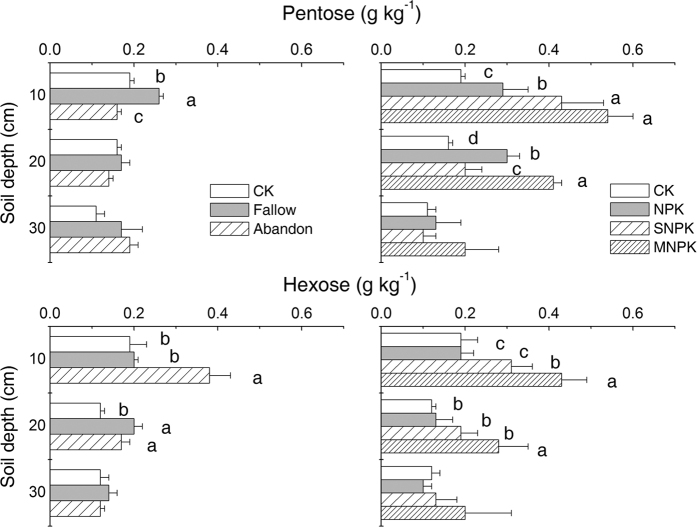
Pentose (top panels) and hexose (bottom panels) concentrations in bulk soils under contrasting soil management regimes (left panel) and fertilizer treatments (right panel).Error bars denote standard deviations (n = 3). Different small letters mean significant differences between treatments, at a given soil depth, at 0.05 (n = 3); no letters mean no significant difference. Two-way ANOVA tests indicated the effects of soil management regimes (P = 0.000) and soil depth (P = 0.000) and their interaction (P = 0.000) on pentose content, and the effects of fertilizer treatment (P = 0.011) and soil depth (P = 0.008) and their interaction (P = 0.020) on pentose content. Two-way ANOVA tests indicated the effects of soil management regimes (P = 0.000) and soil depth (P = 0.000) and their interaction (P = 0.000) on hexose content, and the effects of fertilizer treatment (P = 0.016) and soil depth (P = 0.006) and their interaction (P = 0.155) on hexose content, respectively.